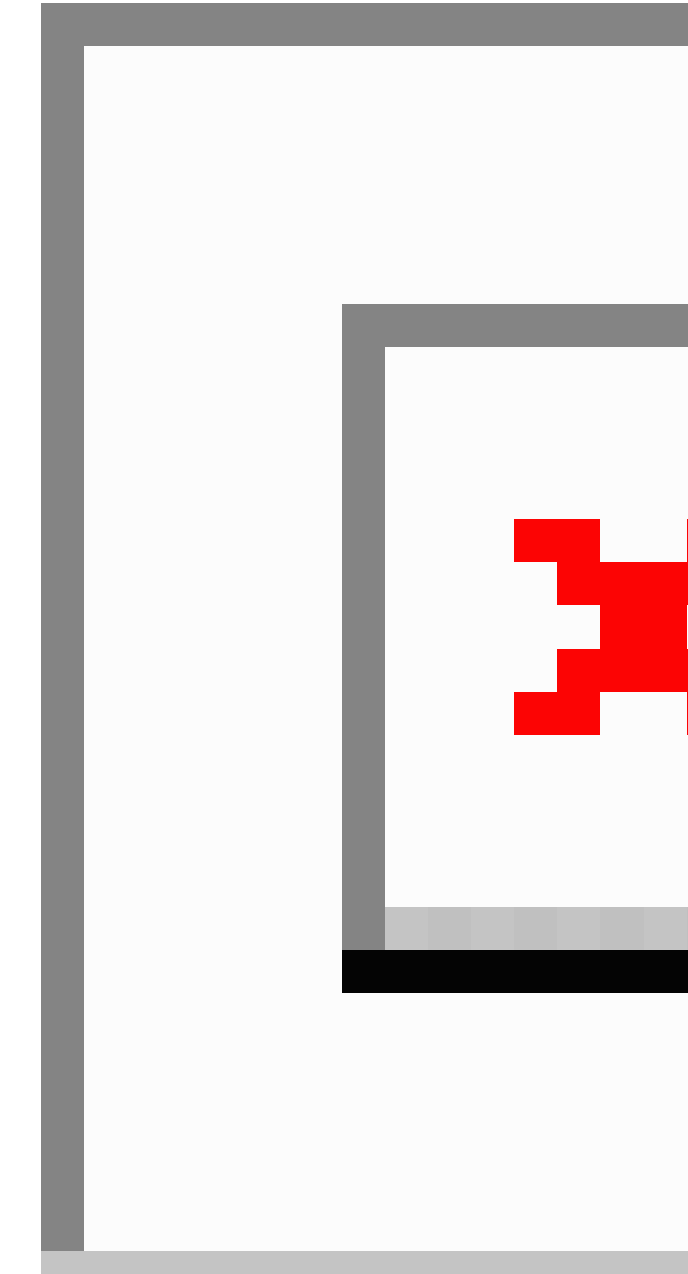
Figure 4. Data flow in the MyFood app. TSD: services for sensitive